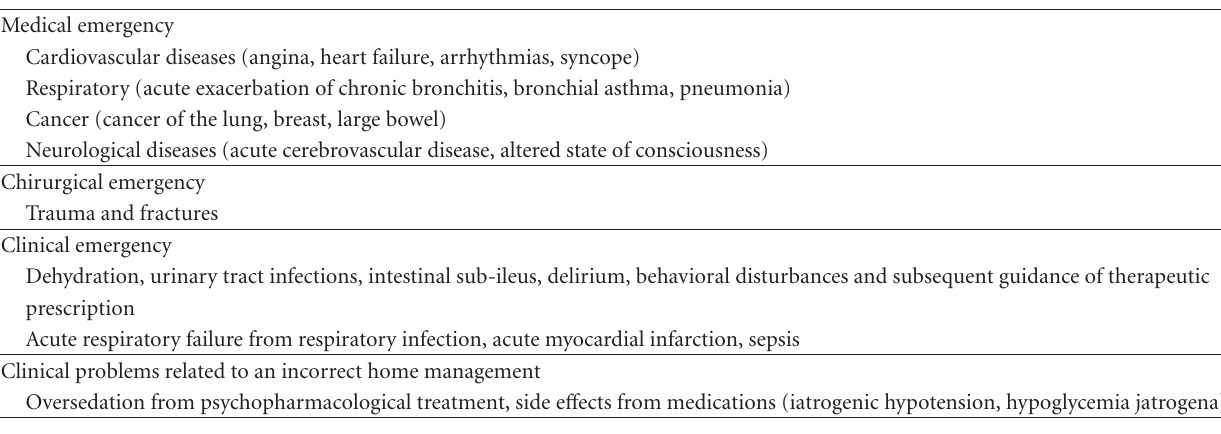
Table 1: The diseases that most often drive the elderly to apply for an urgent evaluation.